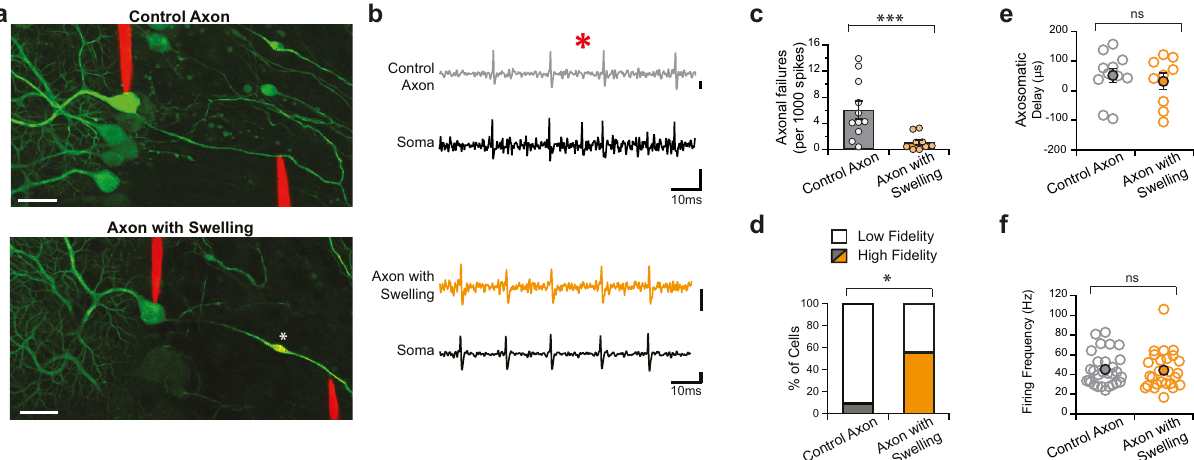
Fig. 1 Axonal swellings are associated with improved axonal propagation of action potentials. a Representative images of a Purkinje cell with placement of electrodes showing simultaneous dual recording from Purkinje cells soma (left electrode) and axon (right electrode) from a control axon (top) and an axon with a swelling (bottom; asterisk indicates swelling). Images were acquired after each simultaneous dual recording. Scale bar, 25 μ m. b Representative traces of dual recordings from soma (black) and axon corresponding to Purkinje cell axons without (top, gray) and with (bottom, orange) an axonal swelling. Red asterisk indicates action potential failures in the axon. Scale bar: 0.5 mV for top two traces, 1 and 0.5 mV for bottom two traces, respectively. c Axonal spike failure rate is signi fi cantly reduced in axons with swellings (Control axon, n = 11; Axon with swelling, n = 9; signi fi cantly different, one-tailed Mann – Whitney U -test; P = 0.001). d Purkinje cell axons with swellings are more likely to be high fi delity transmitters (high fi delity: <1 of 1000 action potentials fail; low fi delity >1 in 1000 action potentials fail) than axons without swellings (two-tailed Mann – Whitney U -test; P = 0.050). e The axosomatic delay between spikes is not signi fi cantly different for control axons (gray) or axons with swellings (orange) (two-tailed Student ’ s t- test, P = 0.59). Axosomatic delay can be negative when the action potential reaches the axonal recording electrode before the somatic electrode, since the spike initiation zone is located in the axon initial segment. f The spontaneous fi ring frequency of Purkinje cells with axonal swellings is not different from cells with control axons. (Firing Frequency: Control axon: 45.2 ± 3.15 Hz; n = 29; Axon with swelling: 44.3 ± 3.71 Hz; n = 26; not signi fi cantly different, two-tailed Student ’ s t- test P = 0.70). Data were presented as mean ± SEM (*** P < 0.005; * P < 0.05; ns P > 0.05). Source data are provided as a Source Data fi